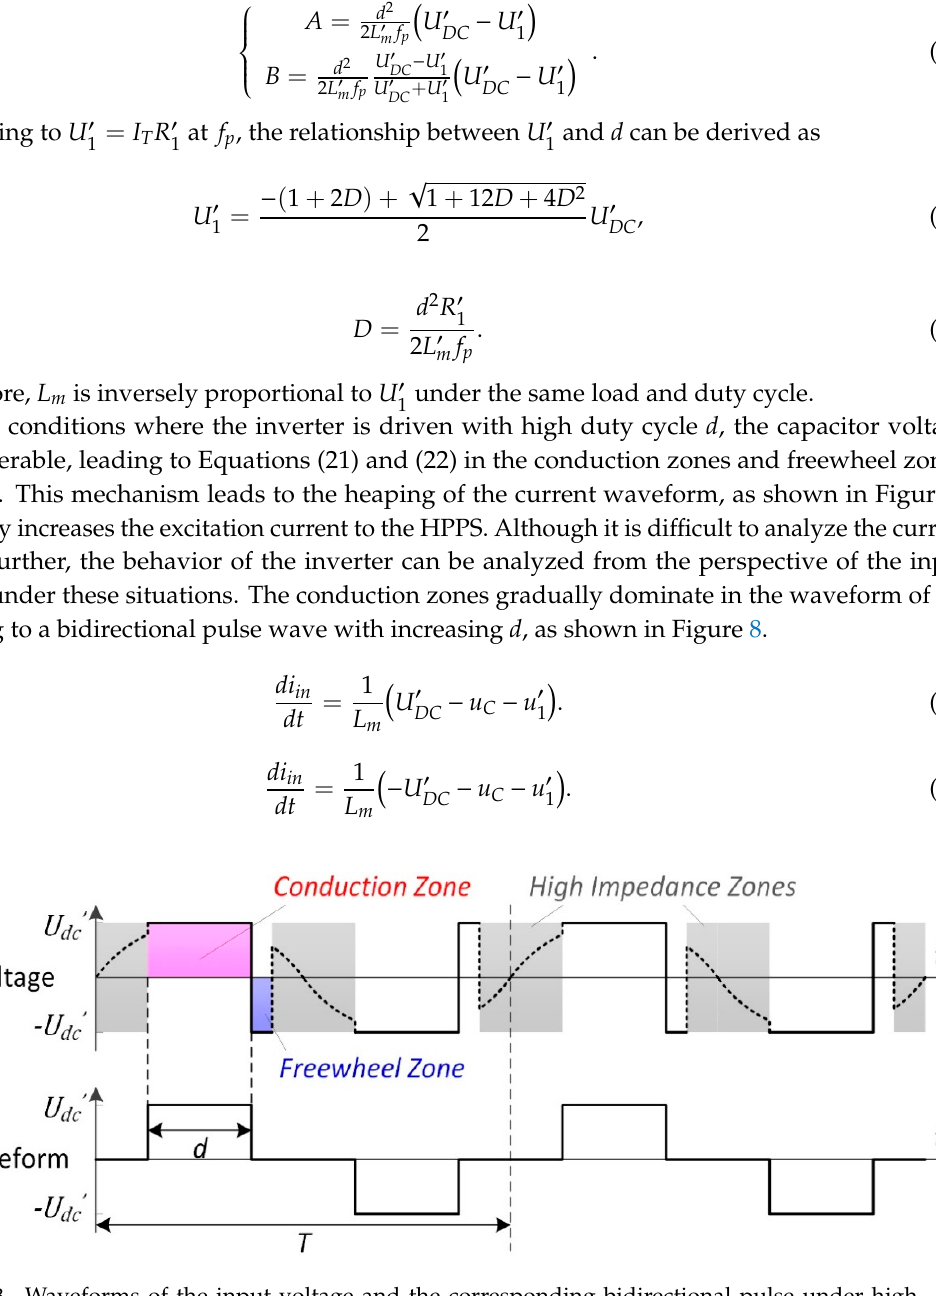
Figure 8. Waveforms of the input voltage and the corresponding bidirectional pulse under high duty